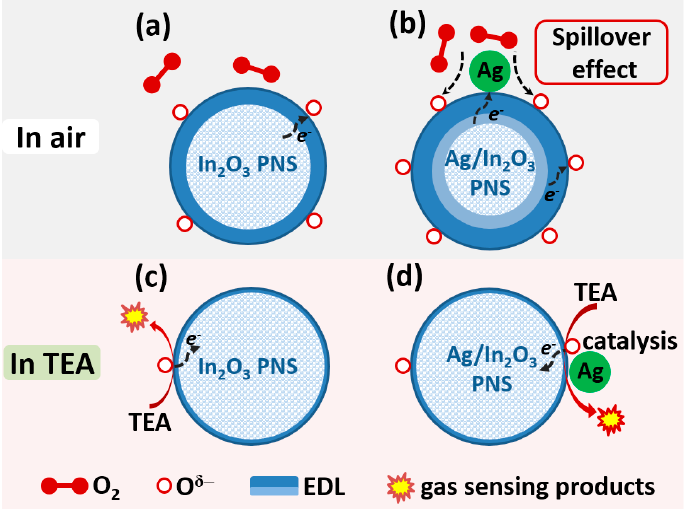
Figure 8. Schematic illustration for the enhanced TEA sensitivity of In 2 O 3 PNS by modifying with Ag nanoparticles.